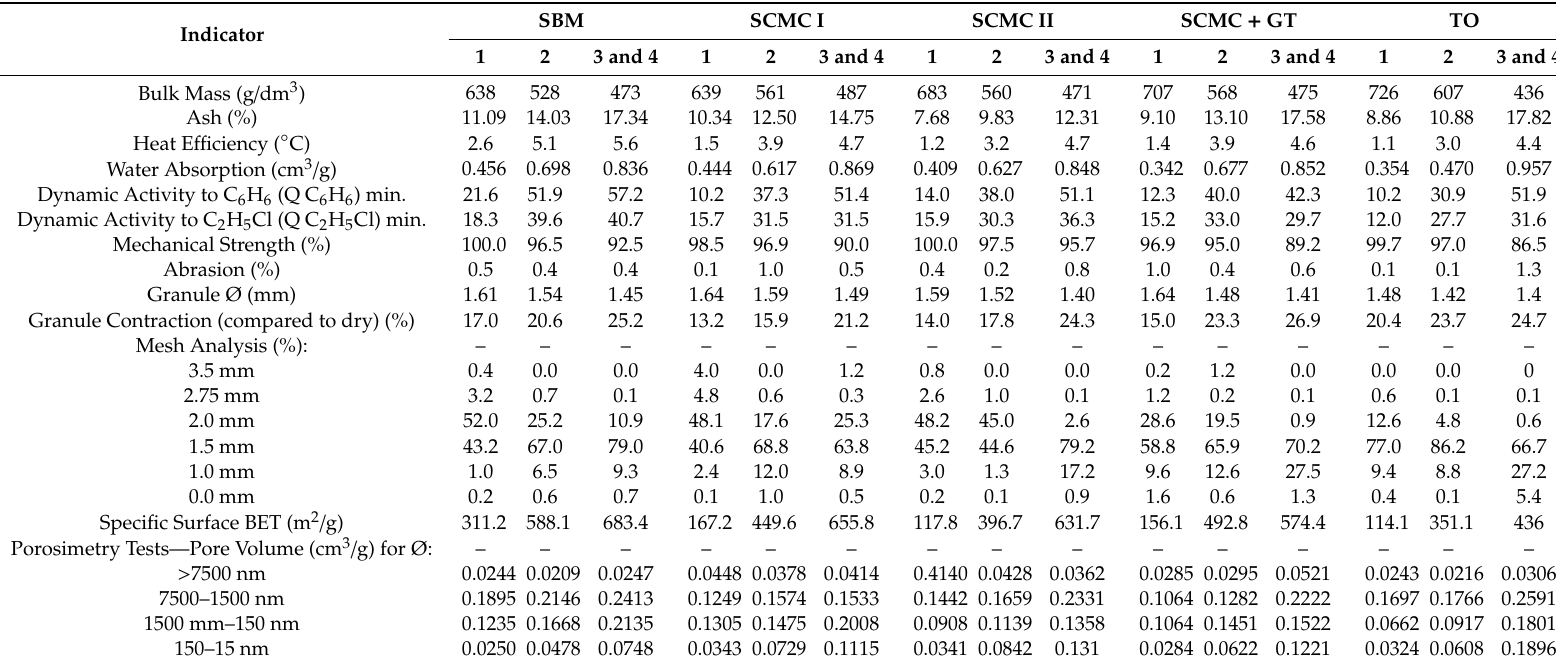
Table 8. Structural parameters of average GAC samples manufactured using the tested binders after the activation